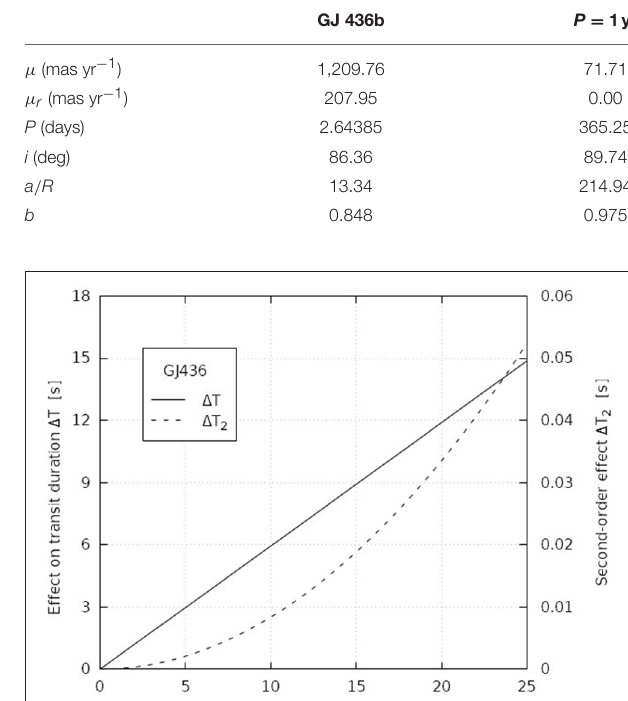
TABLE 1 | Parameters of the transiting planets.